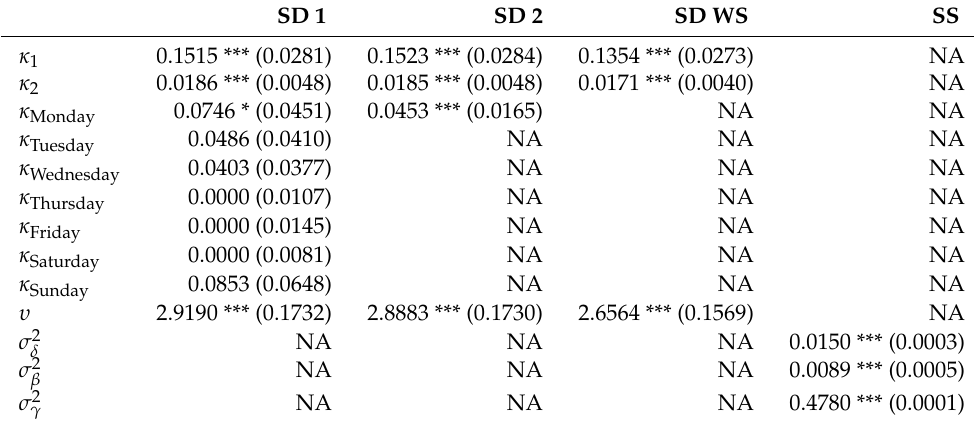
Table A9. Parameter estimates for